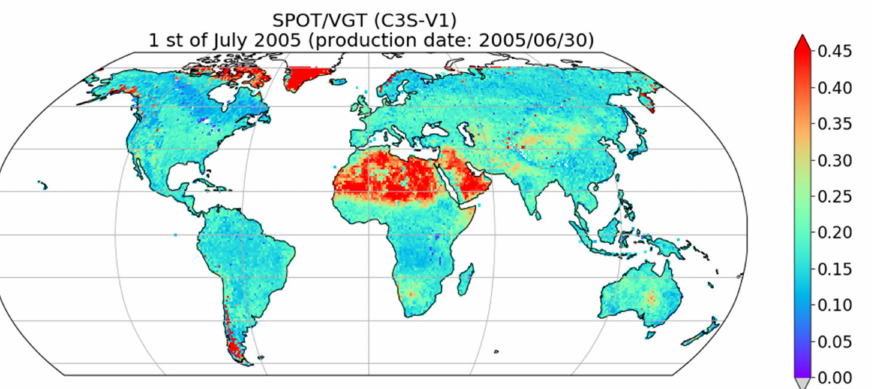
Figure 7. Total shortwave directional-hemispherical albedo (BB-DH) for 1 July 2005 based on SPOT/VGT (C3S-V1).